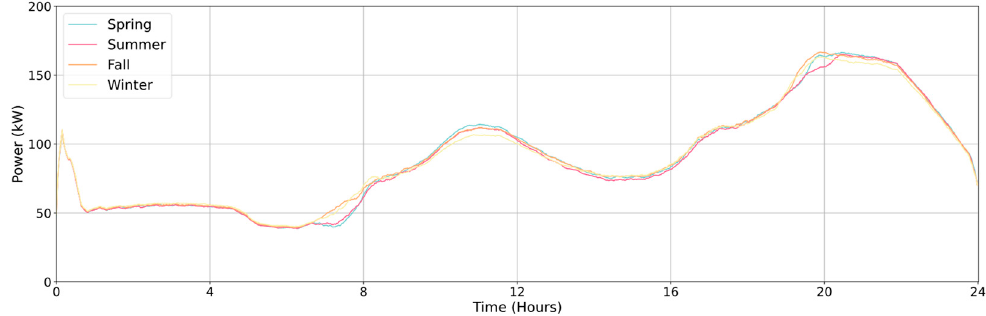
Figure 4. Total electric load profile in an average day in different seasons.